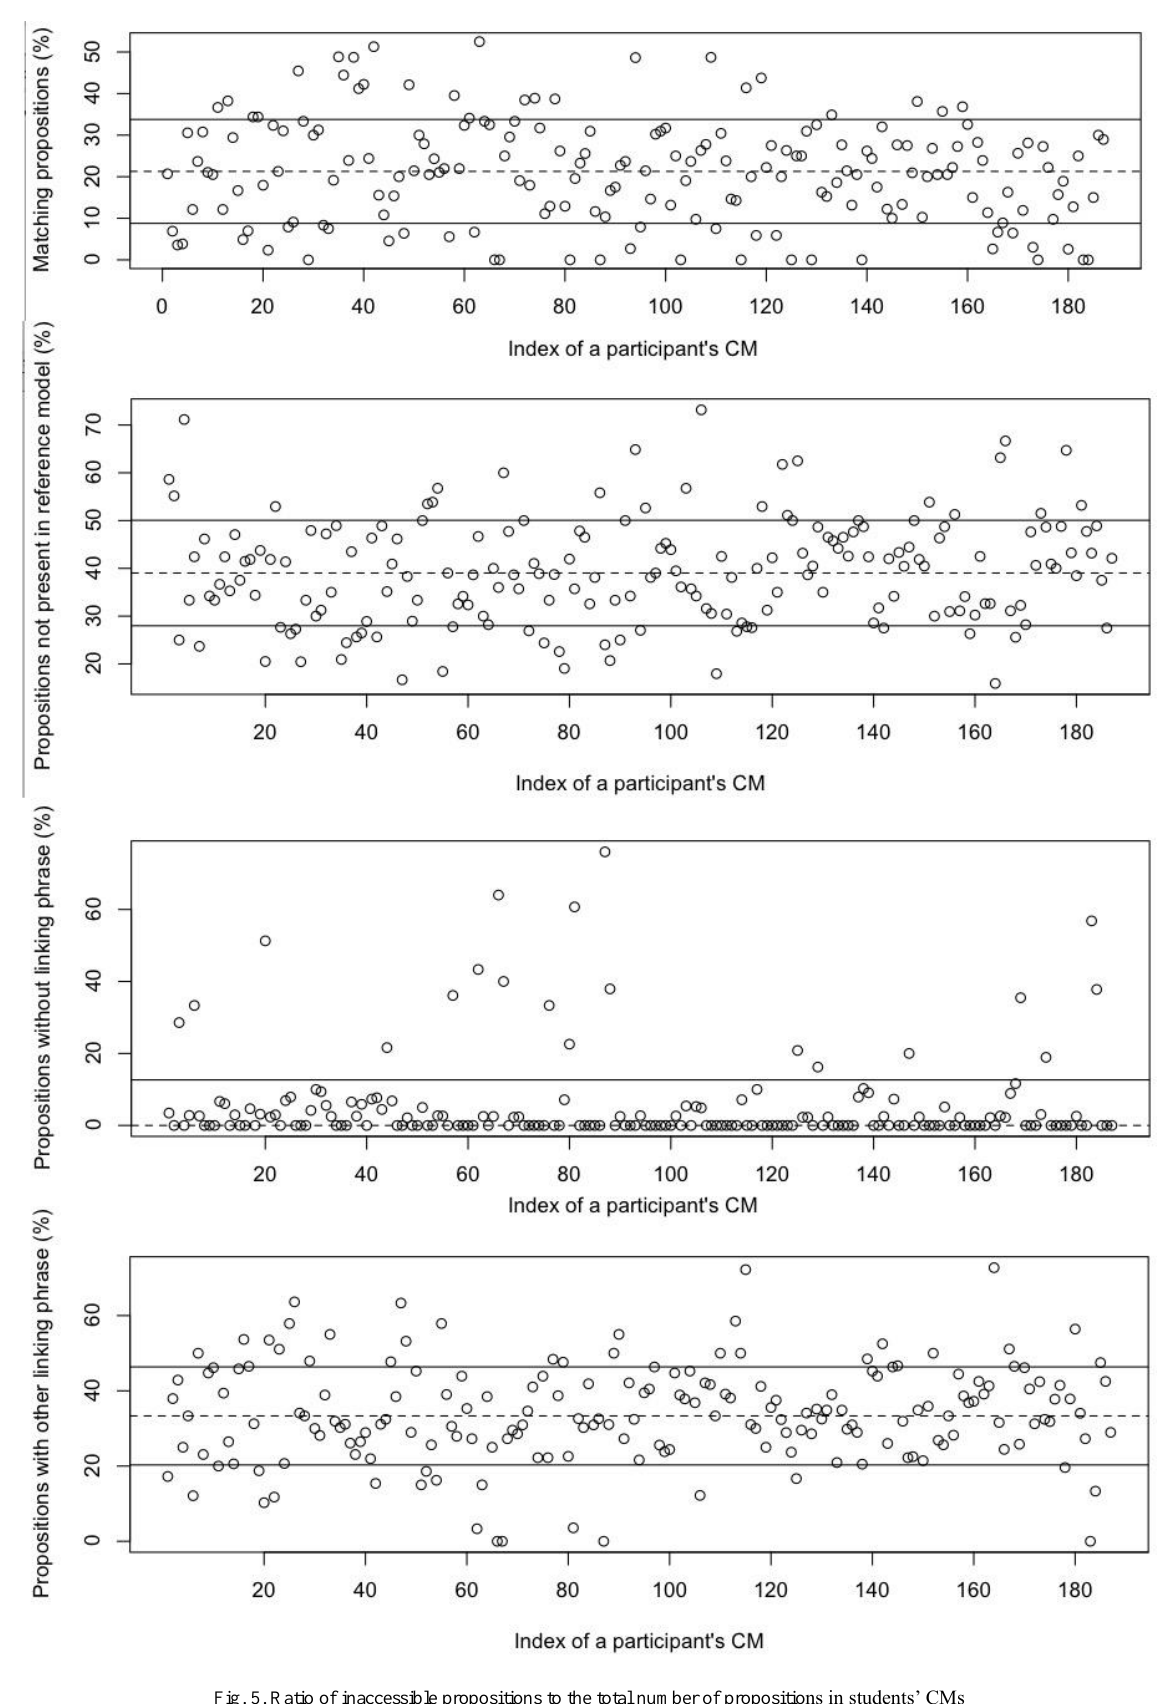
Fig. 5. Ratio of inaccessible propositions to the total number of propositions in students’